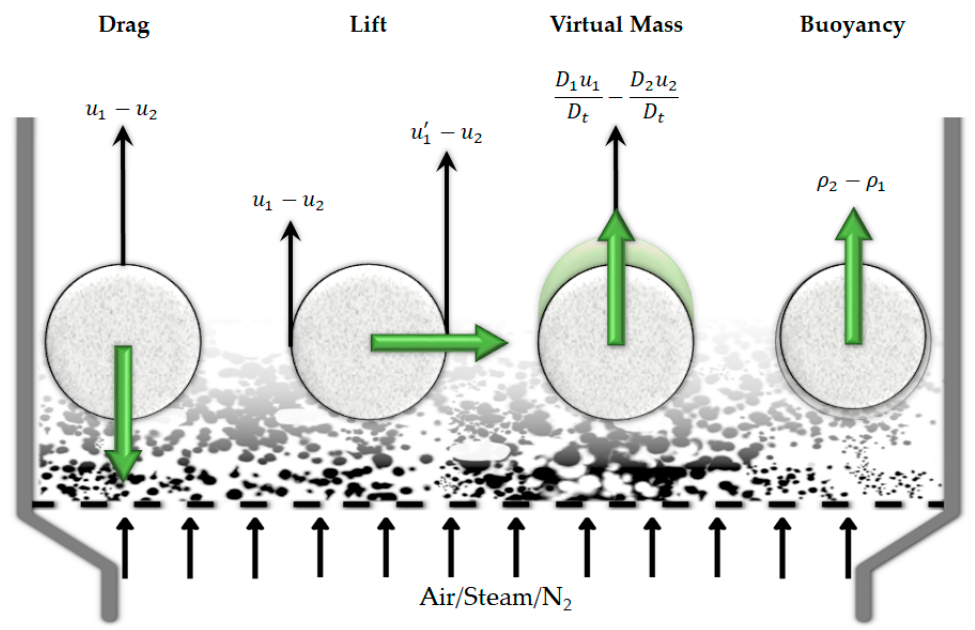
Figure 13. Schematic representation of different forces that contribute to the momentum transfer between phases (adapted from [263]). Indices 1 and 2 are related to the primary/fluid phase and the discrete phase, respectively.